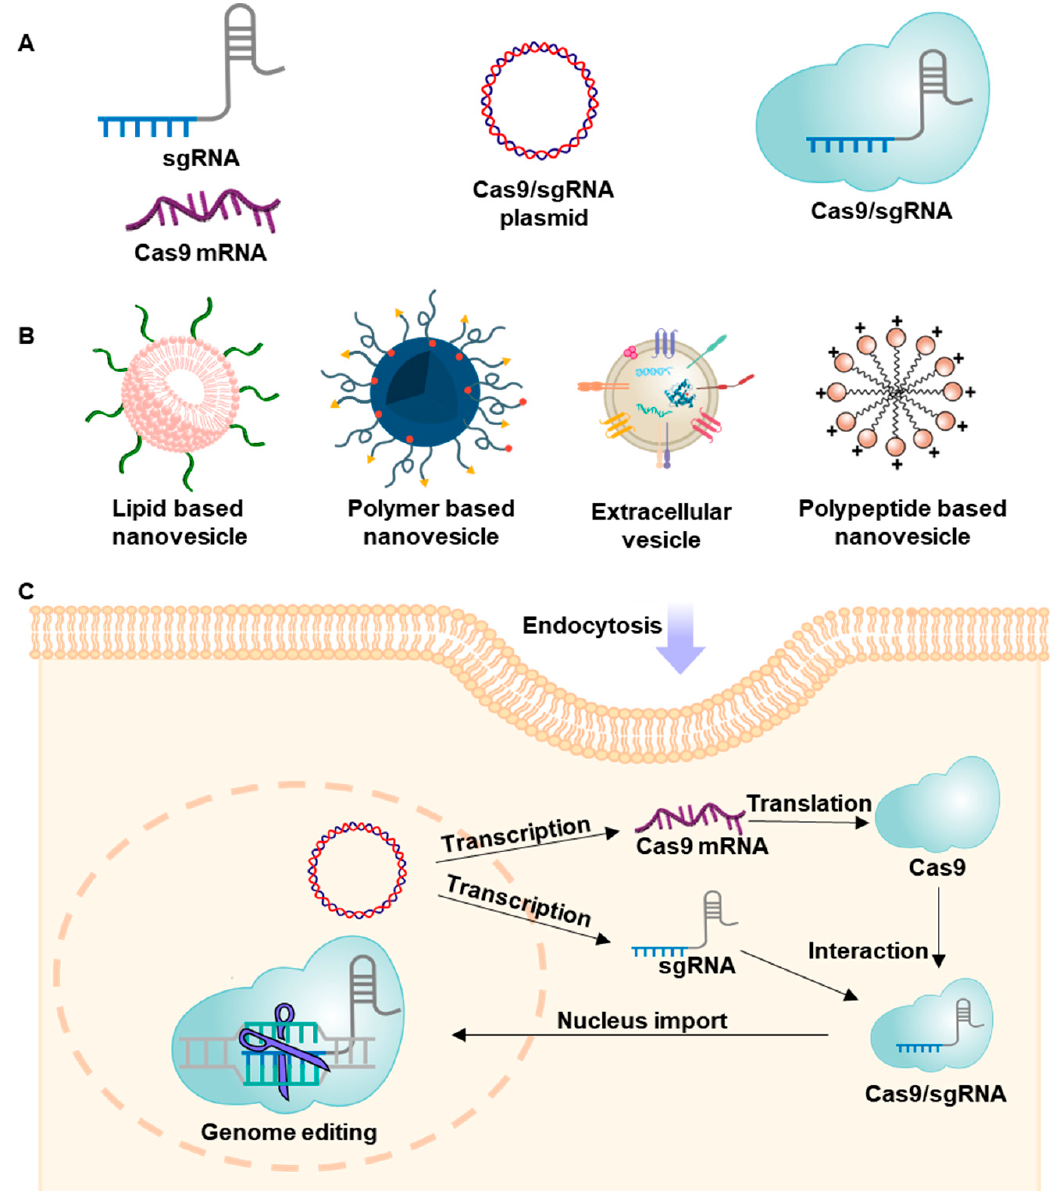
Figure 1. Illustration of nanovesicle types for CRISPR/Cas9 and sgRNA delivery. ( A ) Different forms of the CRISPR/Cas9 system. ( B ) Types of delivery systems for CRISPR/Cas9 and sgRNA. ( C ) Genome- editing mechanisms of nanovesicle-delivered Cas9/sgRNA plasmid DNA. Table 1. Nanovesicle materials for CRISPR/Cas9 and sgRNA delivery.